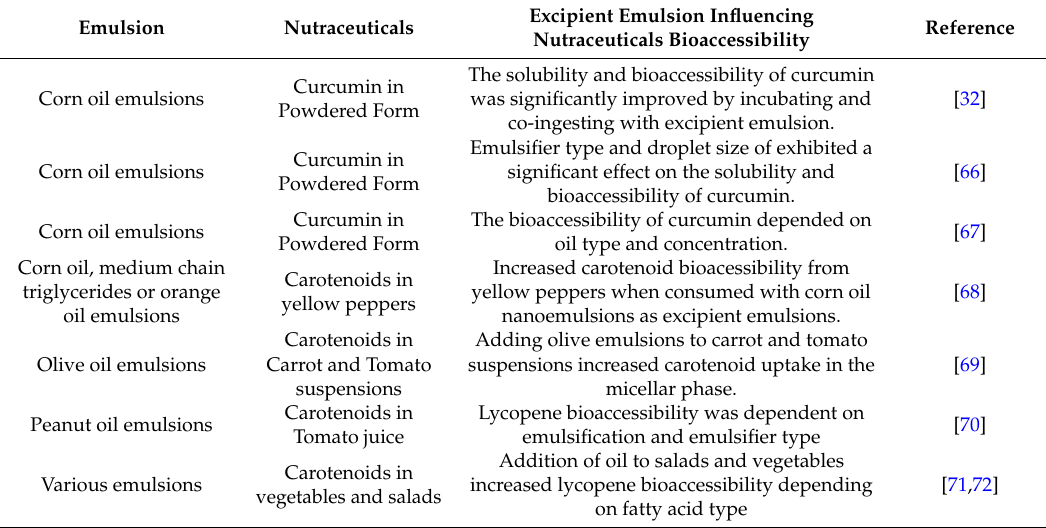
Table 3. Examples of potential excipient emulsions or nanoemulsions to be co-ingested with natural food products to enhance the oral bioavailability of bioactive